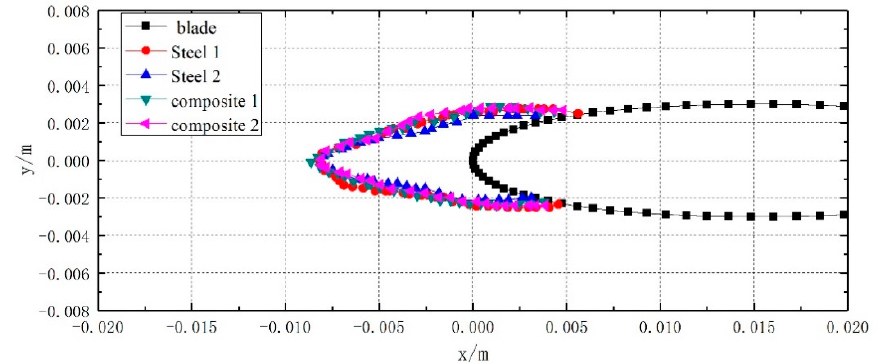
Figure 15. Ice shapes under different blade materials: ( a ) steel material; ( b ) composite material.